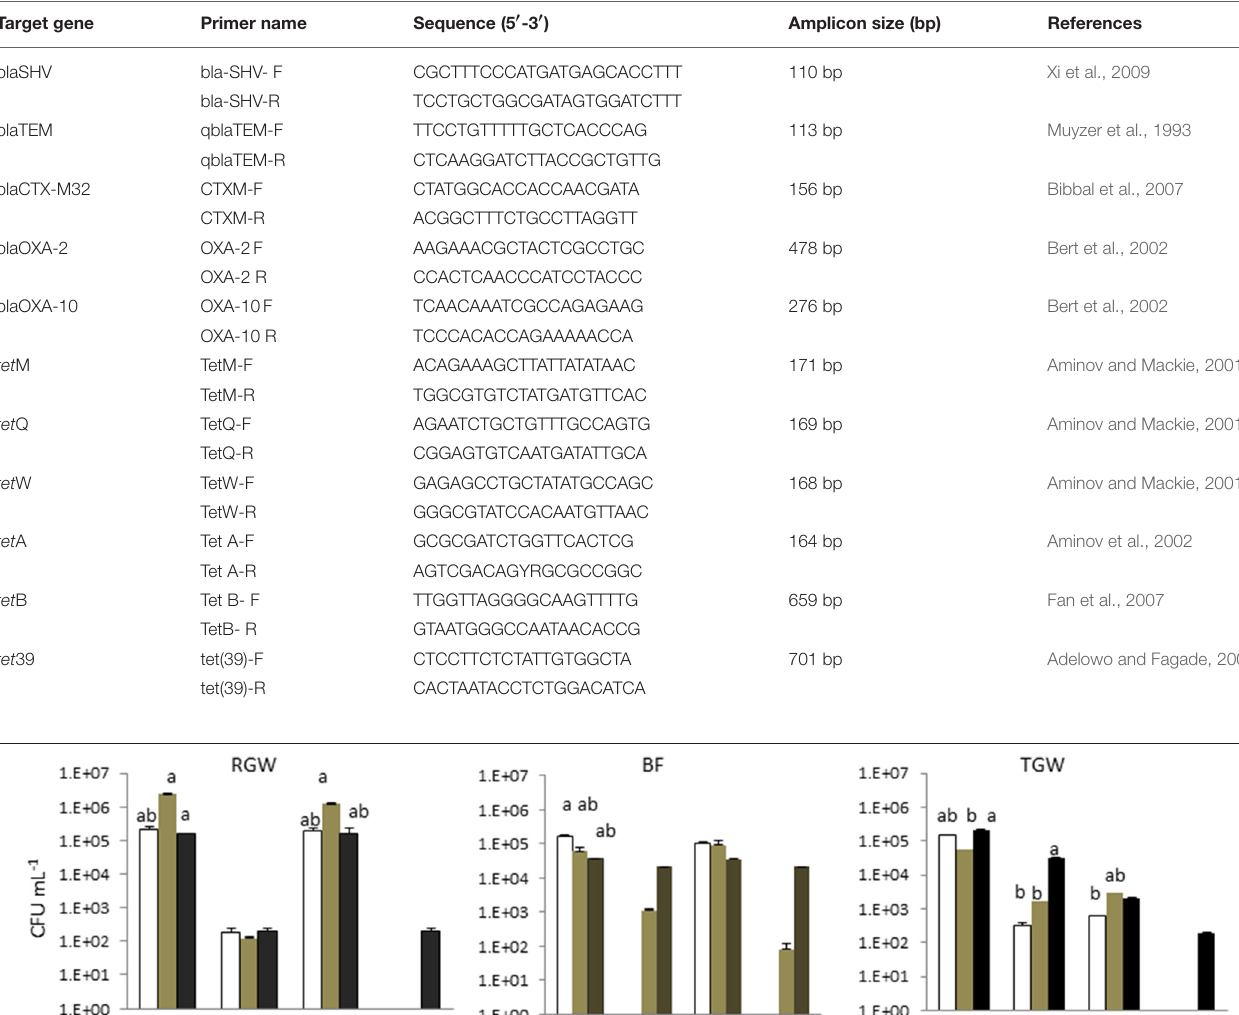
TABLE 1 | PCR primers that were used in the work for screening of isolated strains. Target gene